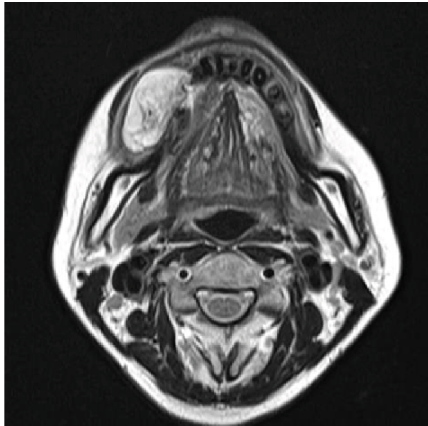
Figure 3: T2-weighted magnetic resonance image. The tumor shows high signal intensity on the T2-weighted image and an oval-shaped neoplastic lesion with a well-de fi ned border of 40 mm × 20mm .